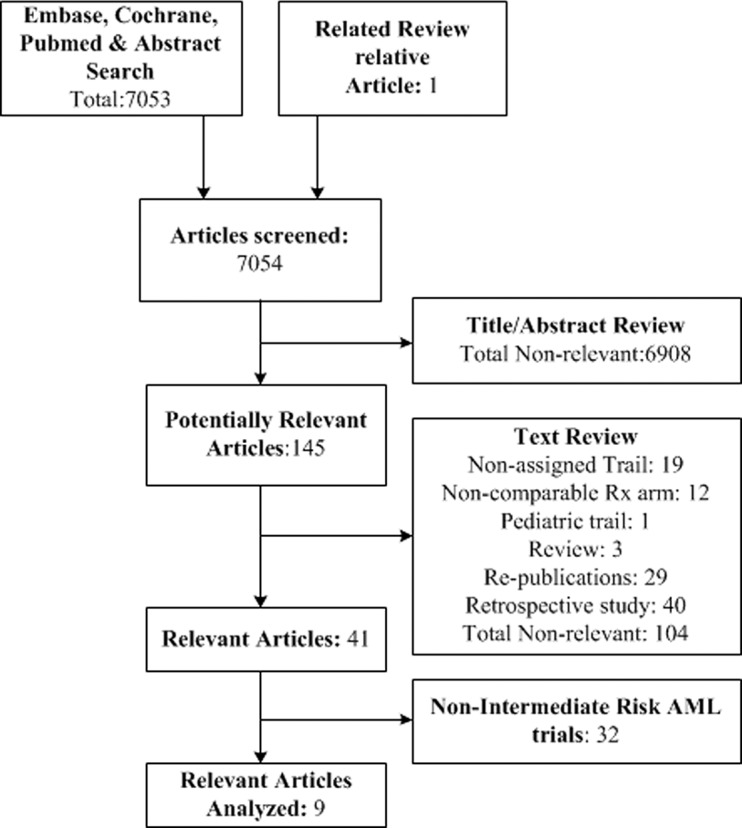
The flowchart of search strategy.